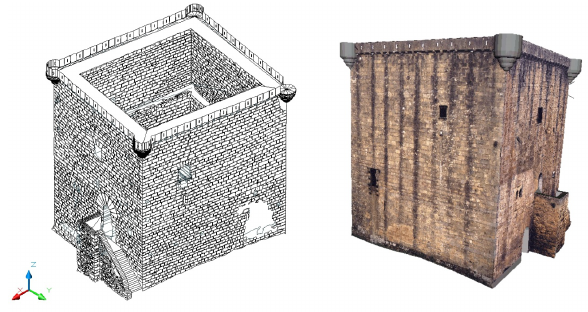
Figure 13. Tower of Martiartu, line drawing from the analog stereopairs (left) and 3D model with photographic textures (right).